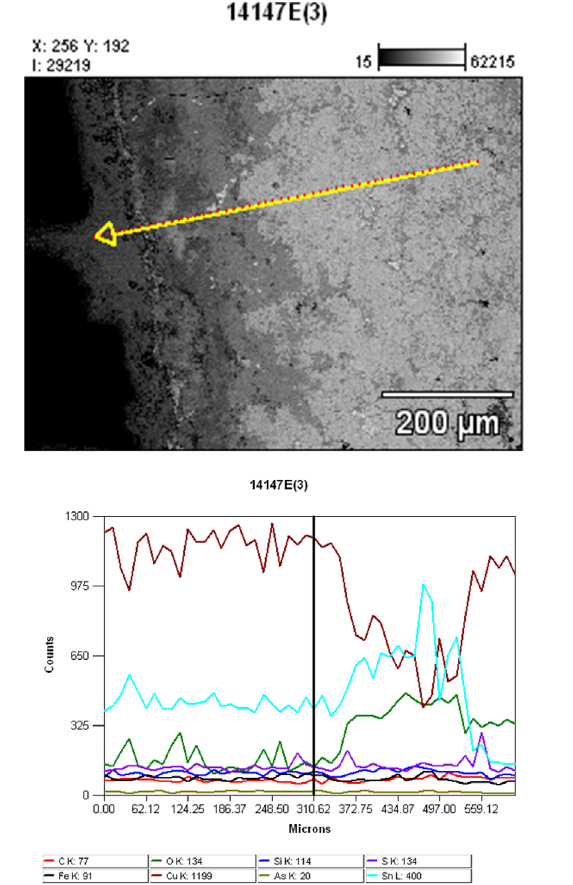
Figure 7. SEM analysis and elemental distribution curve of the specimen sample from the collar (LMN 14147) near Lüneburg (scan: Dirk Kirchner, German Mining Museum,